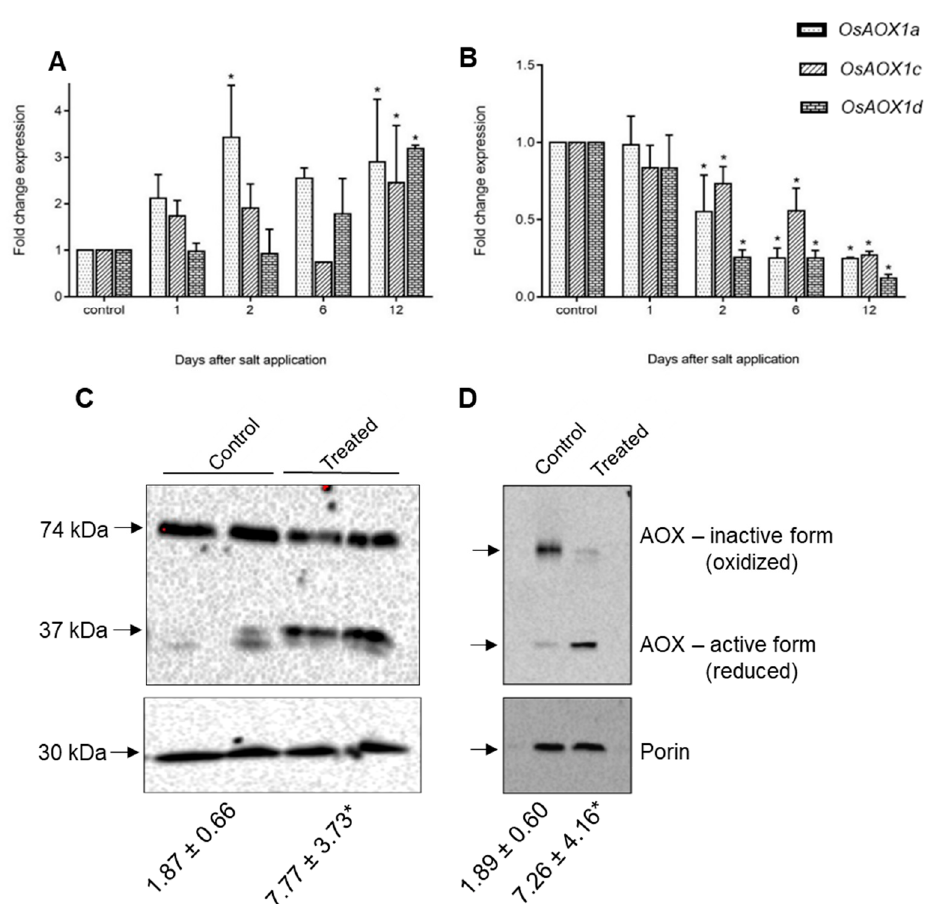
Figure 7. Response of alternative oxidases (AOXs) in rice under salt stress. Fold change expression of AOX isoforms, AOX1a , AOX1c and AOX1d in seedling shoots ( A ) and roots ( B ) were analysed in response to 120 mM NaCl using qRT-PCR over a period of 12 days. Data are shown as the mean ± SE of three biological replicates relative to the control at each time point set as 1.0. Significant differences are indicated by asterisks (*) at p < 0.01 ( t -test). Immunoblots of the AOX protein present in purified mitochondria from salt-treated and non-treated (control) shoots ( C ) and roots ( D ) harvested 9 days after the start of salt application. The numbers below each lane of the blot, represent the AOX capacity determined for the purified mitochondria for that treatment.